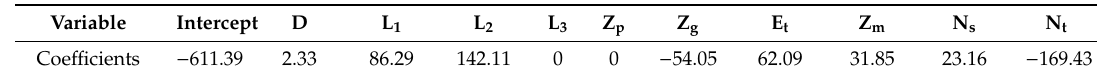
Table 8. MVR coe ffi